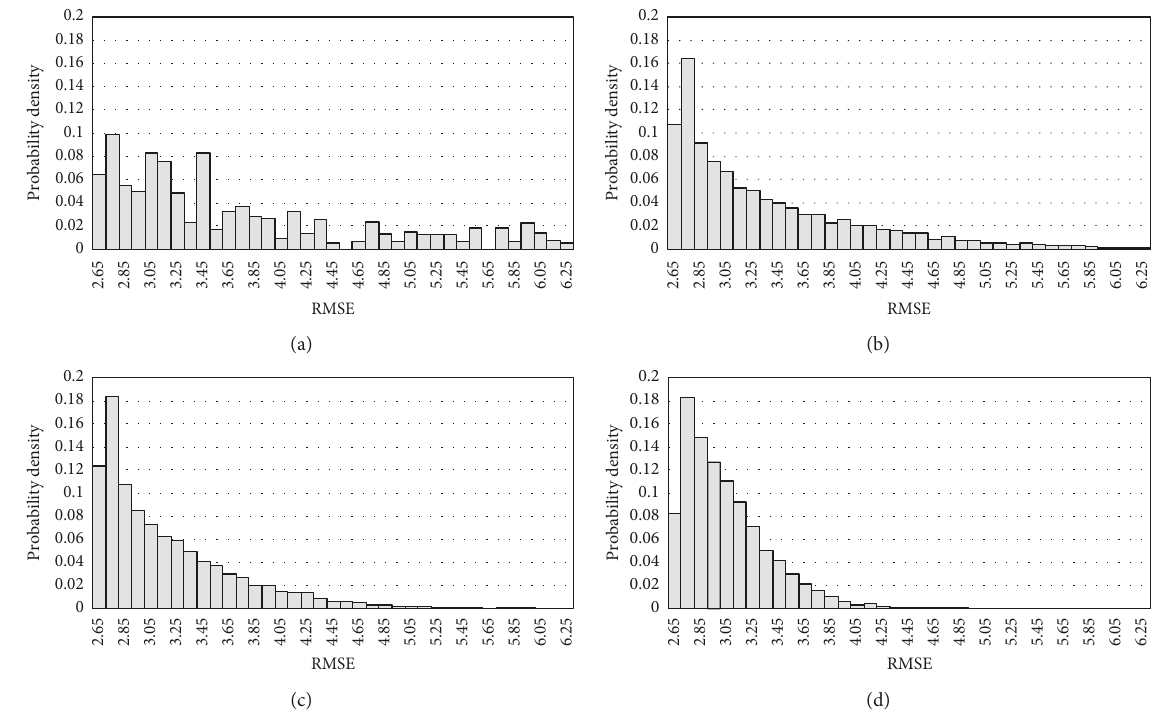
Figure 9: Probability density of RMSE according to calibration: (a) 1-point calibration; (b) 2-point calibration; (c) 4-point calibration; (d) 10-point